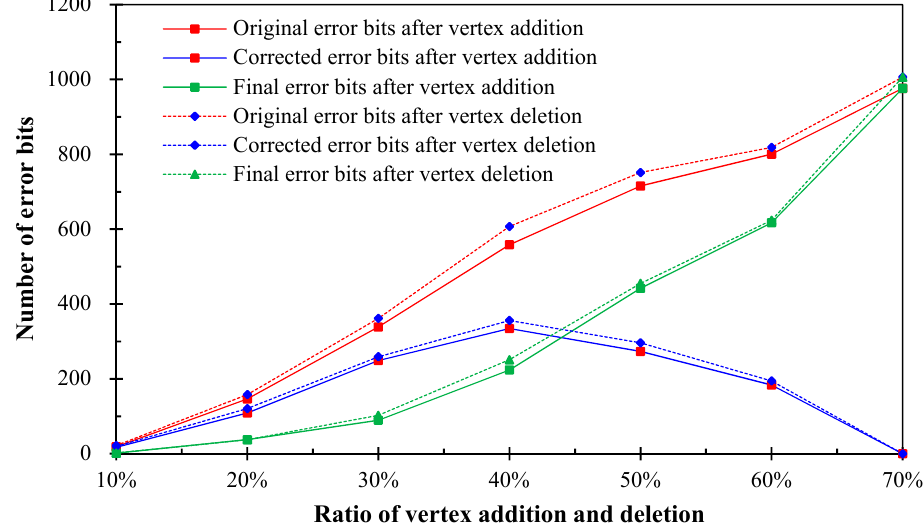
Figure 13. Results of watermark extraction after vertex addition and vertex deletion.